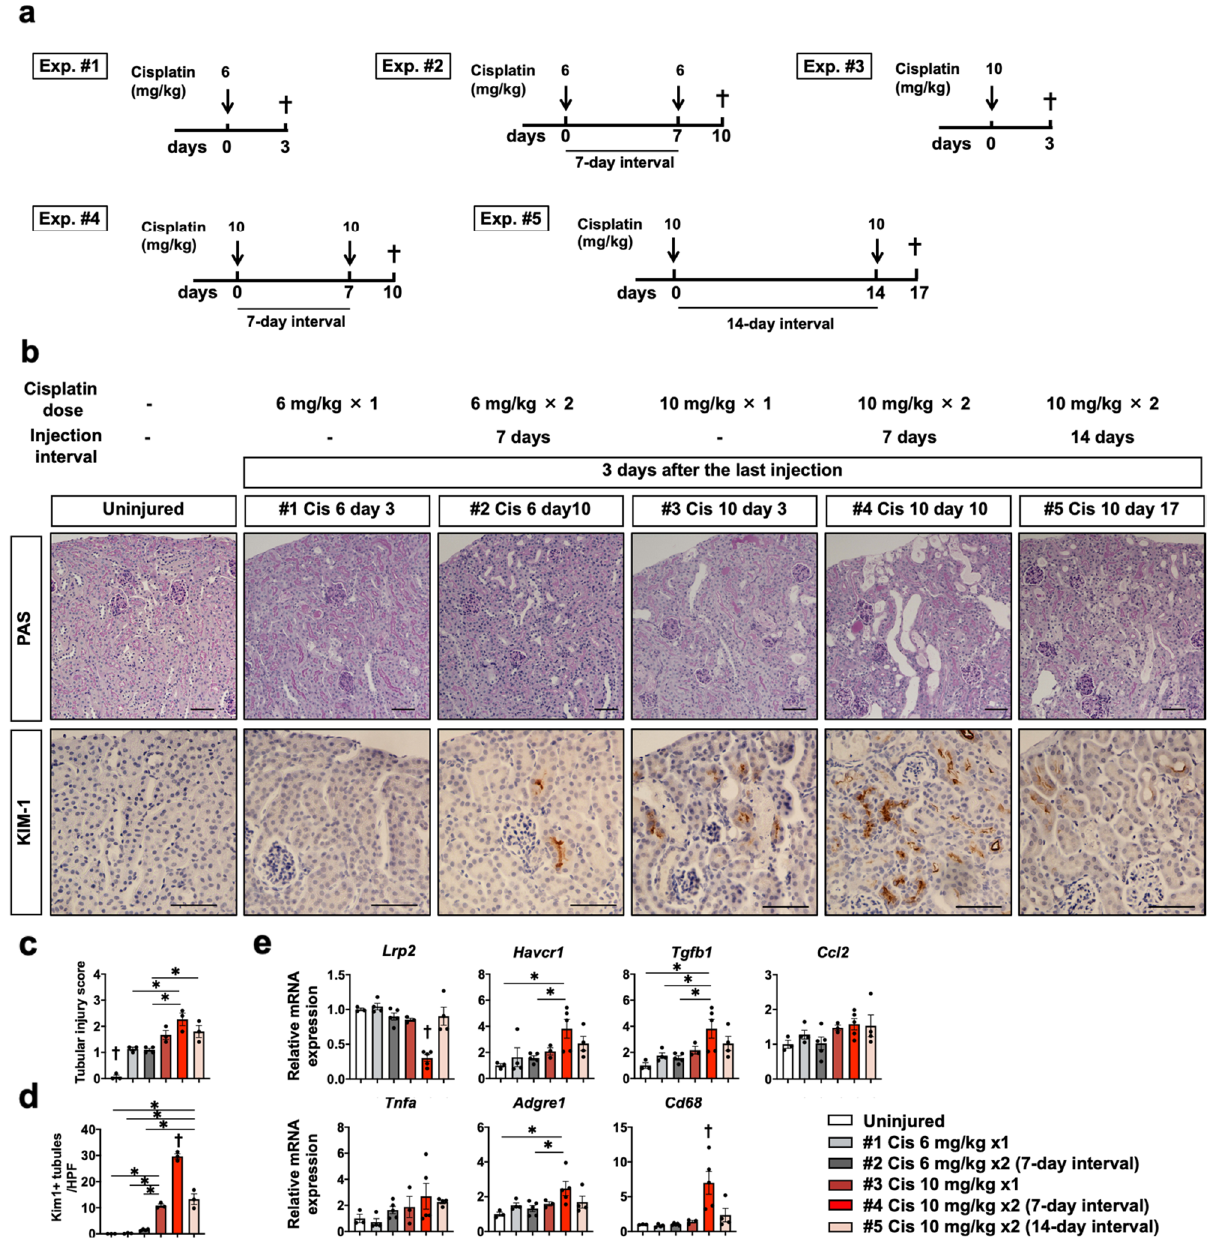
Figure 3. Assessment of kidney injury after different frequencies, doses, and intervals of cisplatin injection. ( a ) Experimental scheme. A single or double dose of 6 or 10 mg/kg of cisplatin was injected at the indicated time point. The kidneys were assessed at three days after the last injection. ( b ) Histological analysis of the kidney. PAS staining and immunostaining of kim-1. ( c , d ). Quantification of the tubular injury score and the number of kim-1 + tubules. ( e ) Quantitative PCR of whole kidneys for the representative markers of mature tubules ( Lrp2 ), tubular injury ( Havcr1 ) profibrotic signal ( TGFb1 ), and inflammation ( Tnfa, Adgre1, Cd68, and Ccl2 ). Data are the mean ± SE. * P < 0.05, † P < 0.05 vs other groups. Scale bar = 100